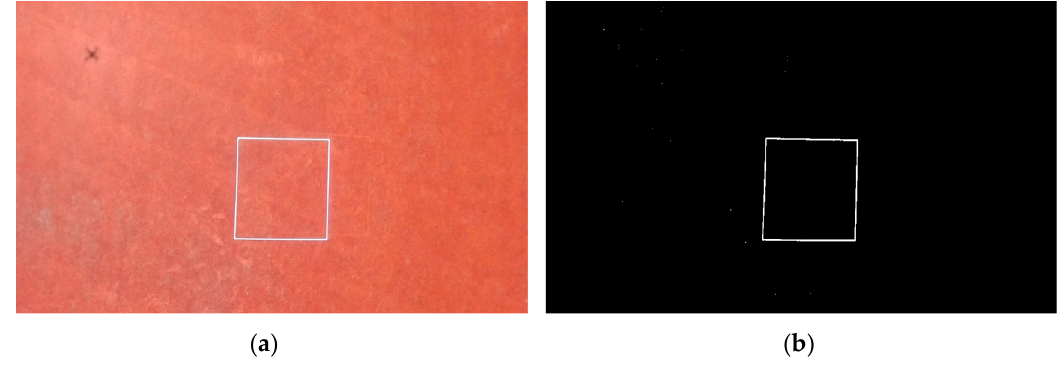
Figure 7. Set point image for the hovering test. ( a ) Original image for hovering test; ( b ) Segmented image of PVC square.